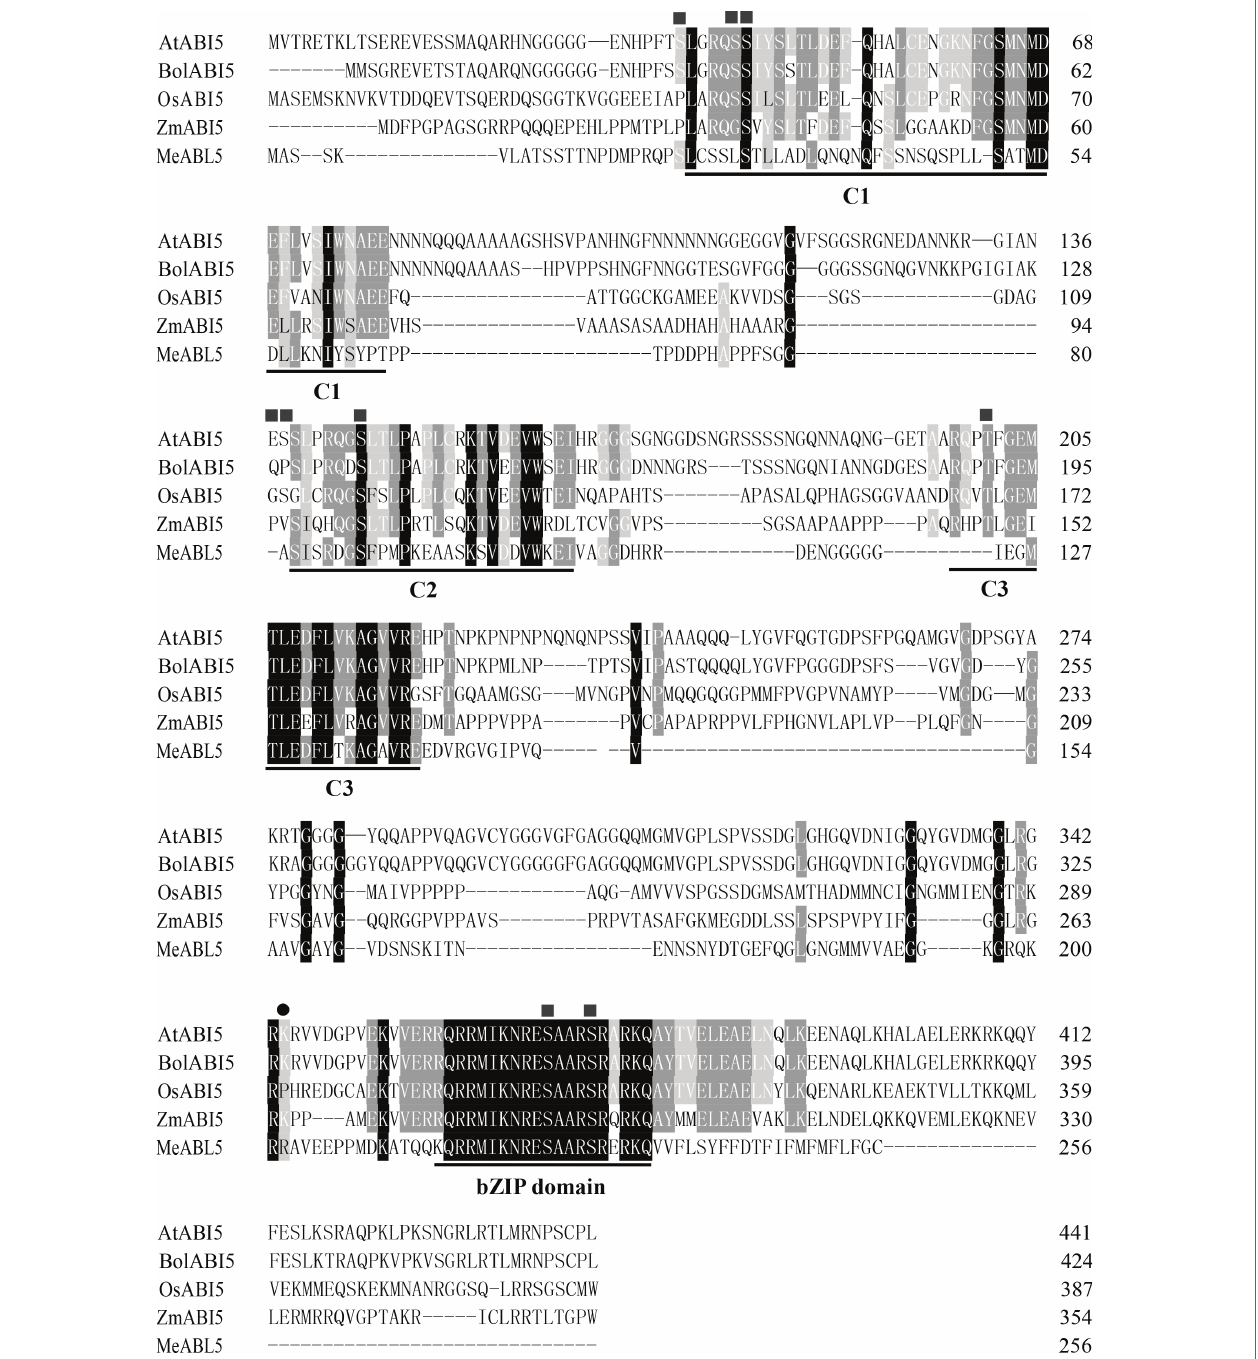
FIGURE 2 | Alignment of MeABL5 and other ABI5 proteins. The amino acid sequence of MeABL5 was aligned with AtABI5 (Arabidopsis thaliana, AAD21438.1), BolABI5 ( Brassica oleracea , JX870620.1), OsABI5 ( Oryza sativa , ABM90395.1), and ZmABI5 ( Zea mays , NP_001150949). The squares and circles mark phosphorylation and ubiquitination sites, respectively. C1, C2, and C3, conserved regions; bZIP, basic leucine zipper